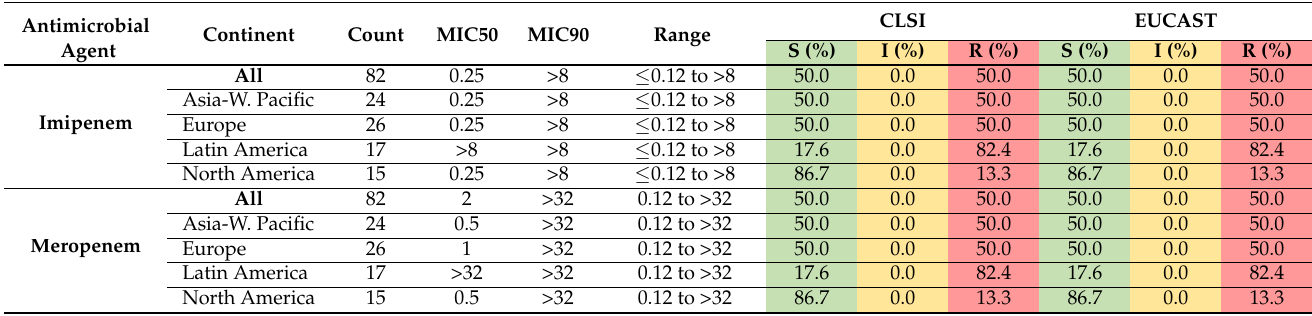
Table 3. Activity of antimicrobial agents tested against 82 Acinetobacter isolates from intra- abdominal